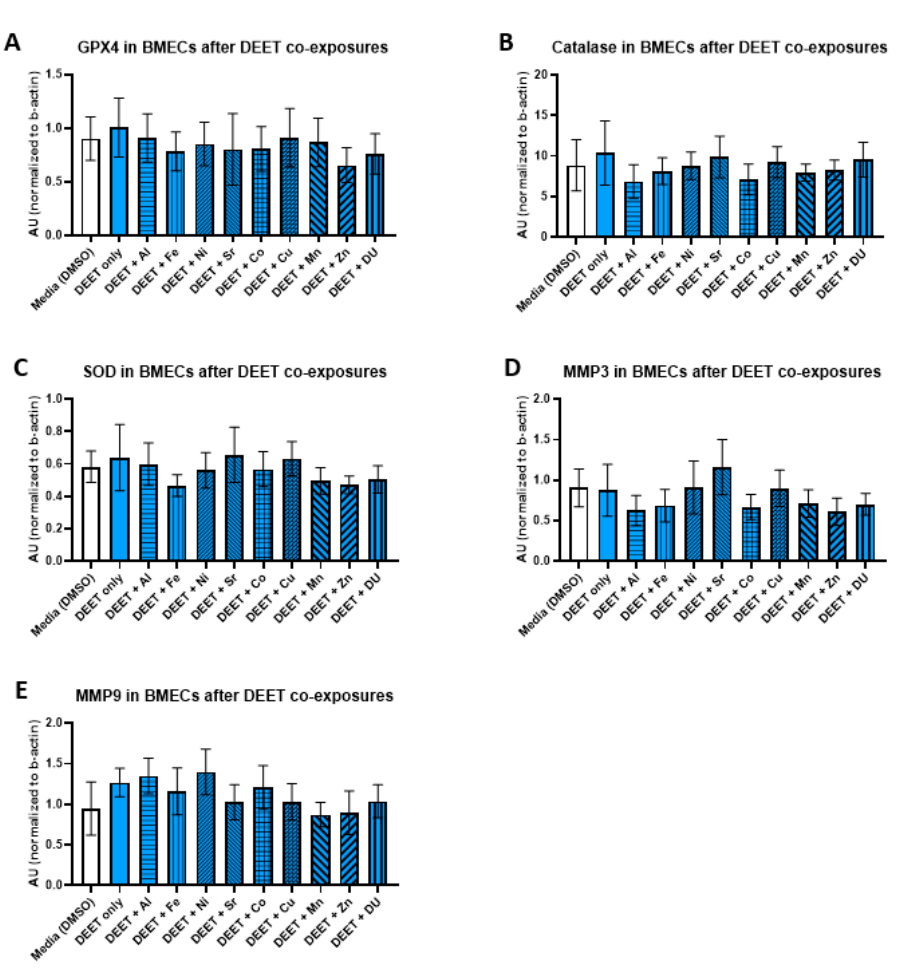
Figure 5. Oxidative stress proteins in brain microvascular endothelial cell (BMEC) cultures after DEET and metal exposure. Assessment of several oxidative stress related protein levels in BMEC cultures after exposure to DEET (10 µM) and metals (1 µM). ( A ) GPX4 expression, ( B ) catalase expression, ( C ) SOD expression, ( D ) MMP3 expression, and ( E ) MMP9 expression. All assessments are from the same